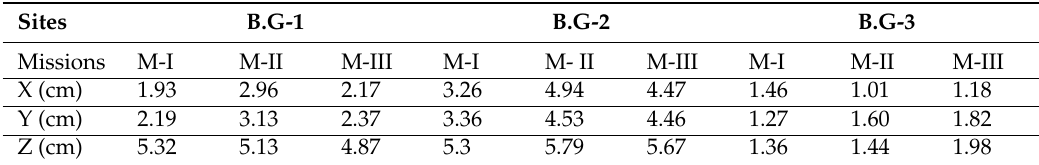
Table 3. Errors in X, Y and Z of the three